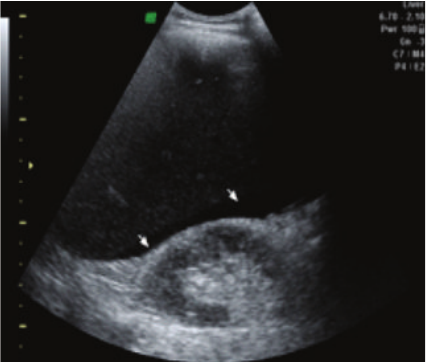
Figure 2: US image shows small collection of fluid in hepatorenal